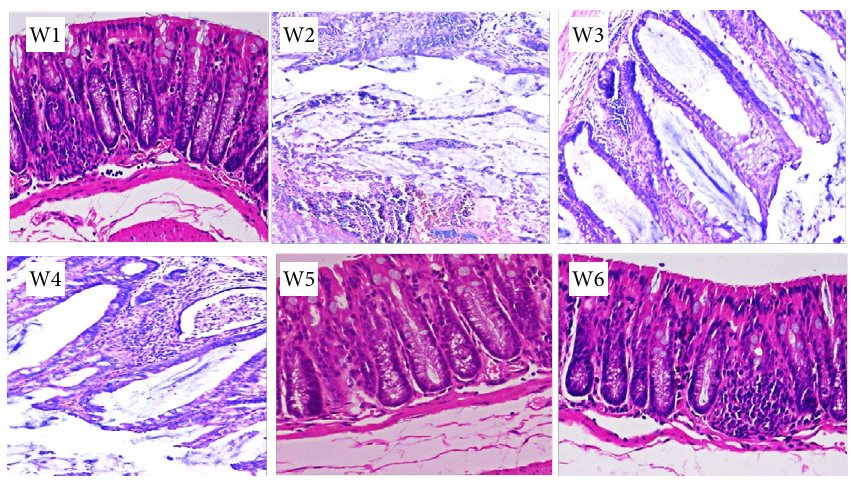
Figure 5 - HE staining of rat